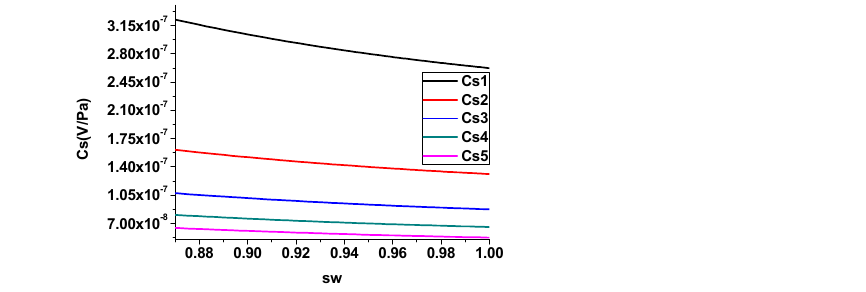
Figure 6. Influence of viscosity on streaming potential coupling coefficient (bubbly flow).